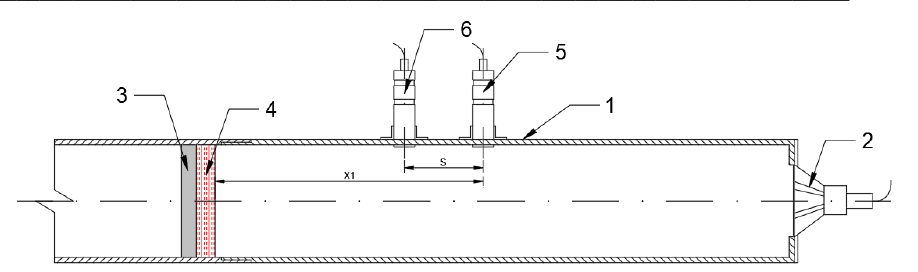
Fig. 4. Impedance tube principle scheme: 1 – impedance tube shell (acrylic glass), 2 – sound speaker, 3 – rigid backing, 4 – sound absorption sample, 5 – microphone No. 1, 6 –microphone No. 2 I mpedance tubes differ in their parameters depending on the properties to be